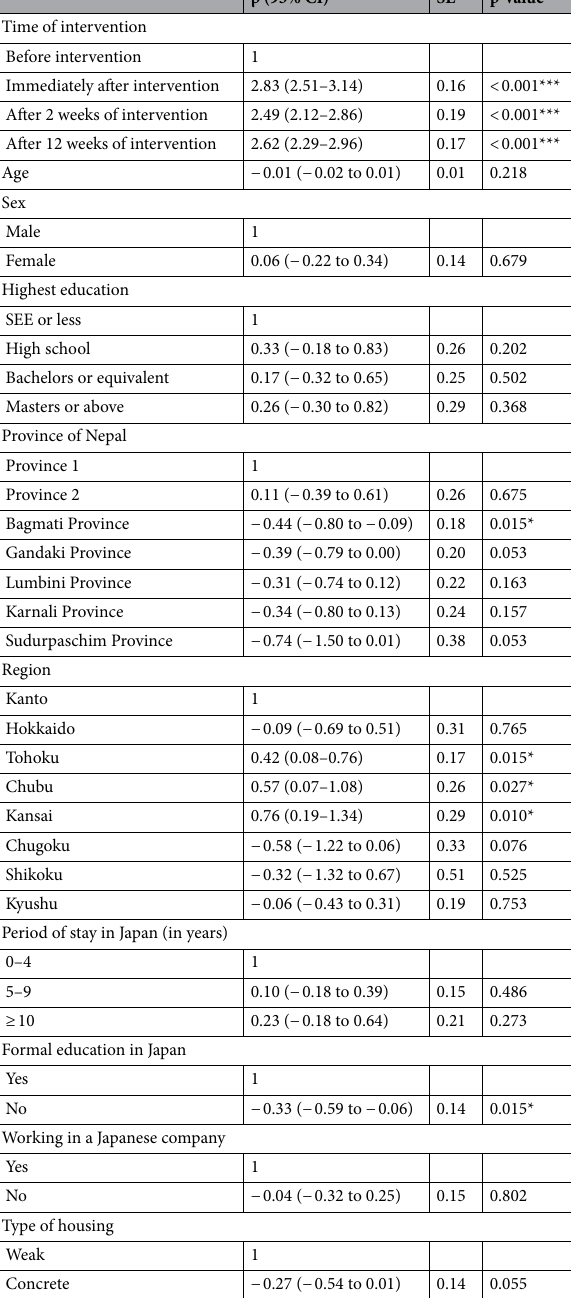
Table 3. Generalized estimating equation model for earthquake preparedness practice among Nepalese immigrants residing in Japan (N = 165). SEE Secondary education Examination, SE robust standard error,